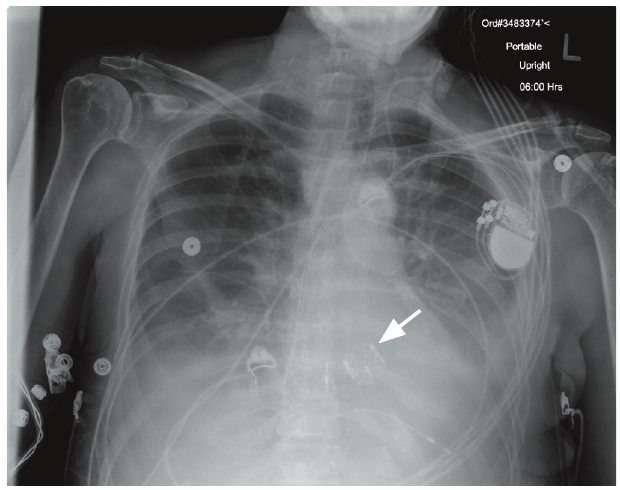
Fig. 3. AP radiograph showing valve prosthesis in situ